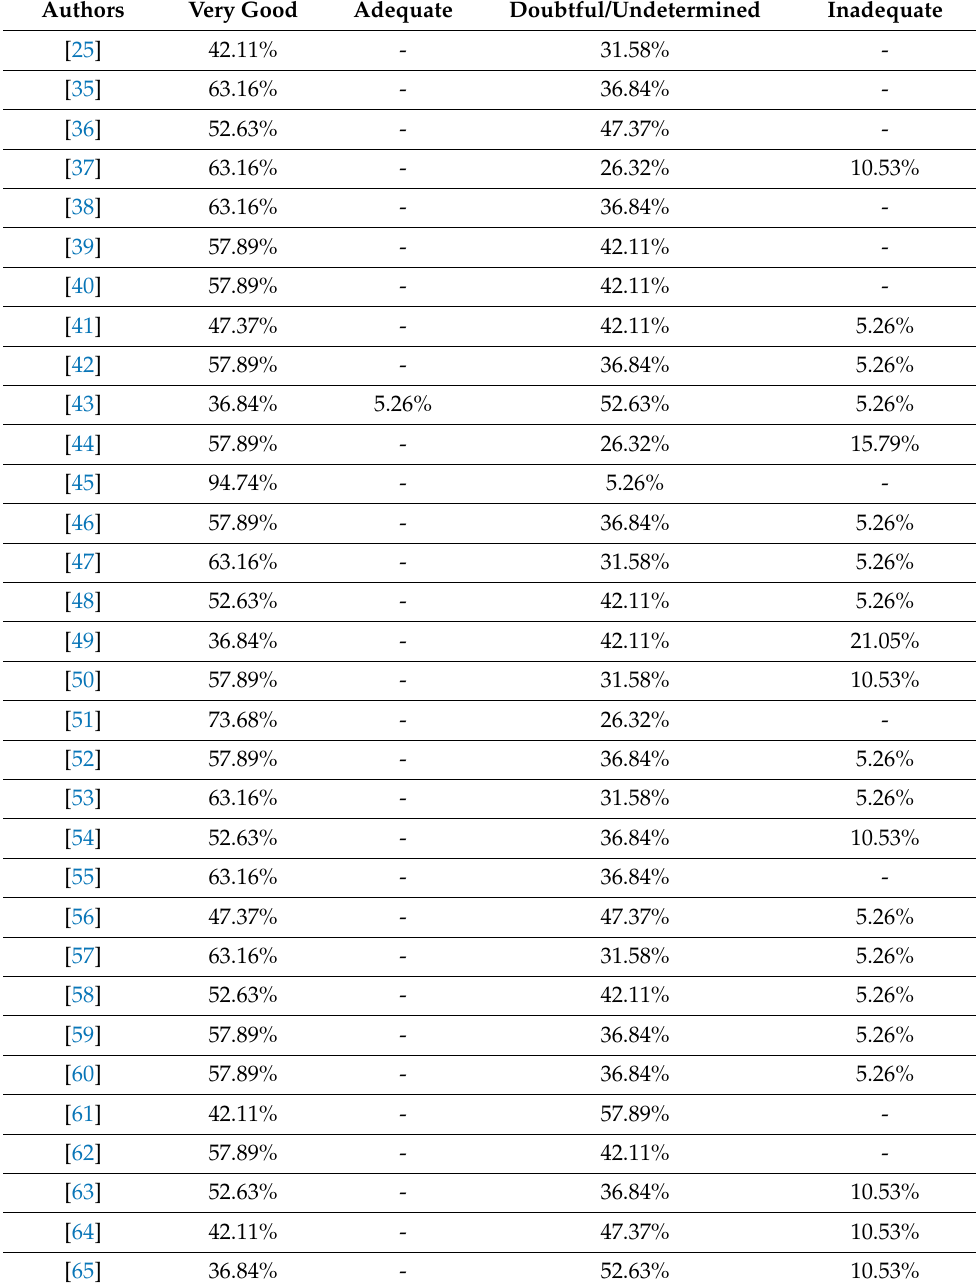
Table 6. Analysis of the quality of studies using the COSMIN